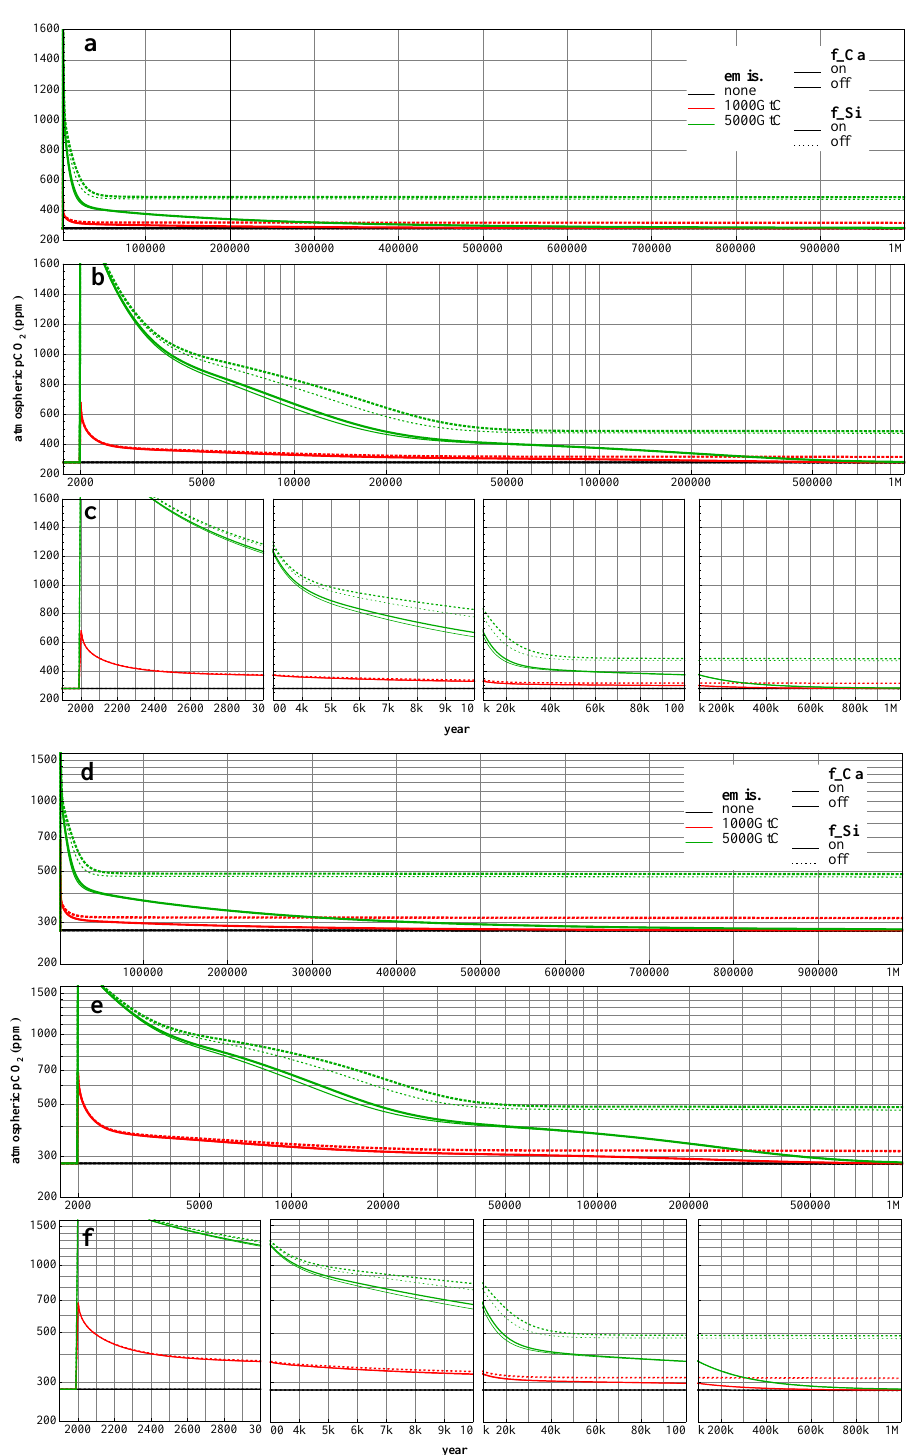
Fig. 3. Time series visualisation using an example result of atmospheric p CO 2 (dependent variable) over 1Myr for two different emissions pulses: linear (a, b, c) and logarithmic (d, e, f) scales for dependent variable with a linear timescale (a, d) , a logarithmic timescale (b, e) , and multiple linear timescales (c, f) ; multiple linear scales for both the dependent variable and time (g) ; separate plots for each emissions scenario (h)